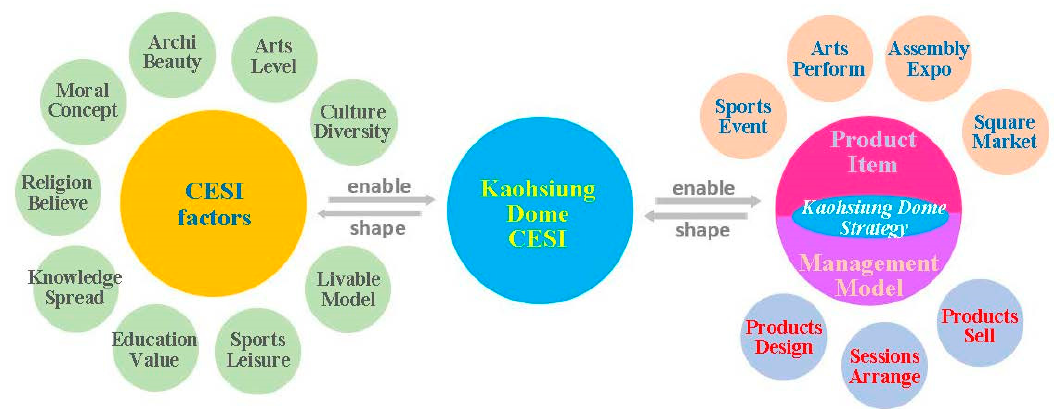
Figure 11. Concept of Kaohsiung Dome Cultural Ecosystem Service Innovation. Figure 12 represents the CESI framework of Kaohsiung Dome and services. The services